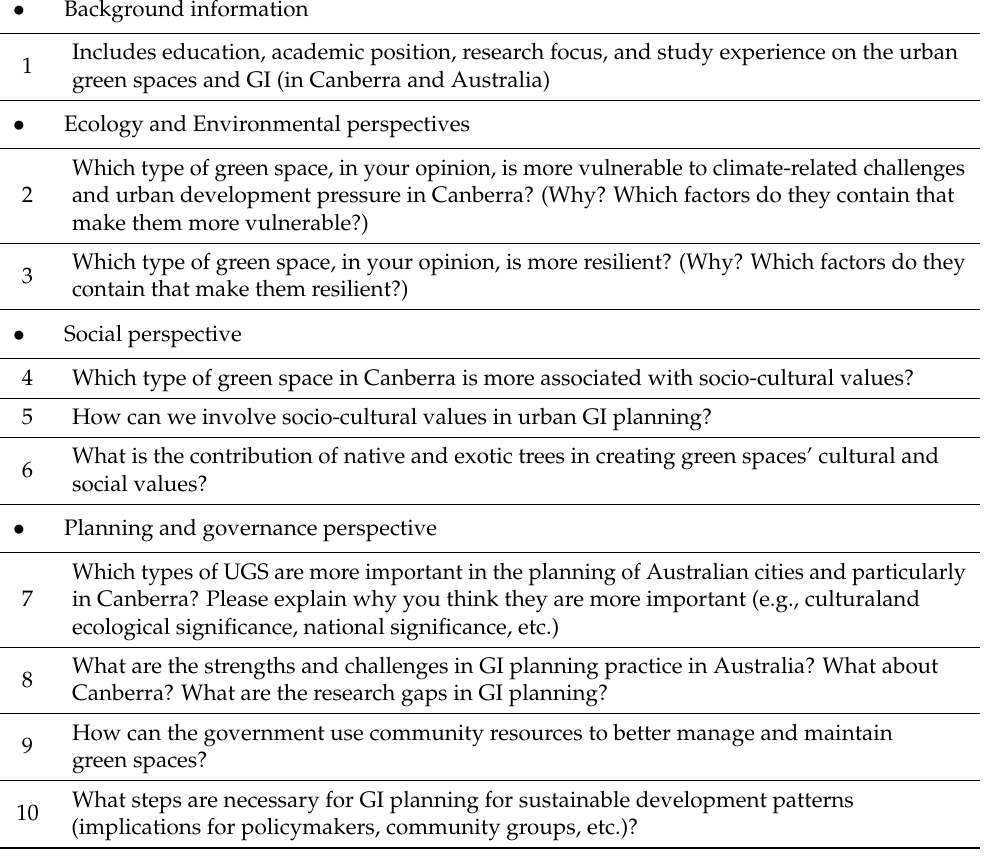
Table 2. Open-ended questions designed for the